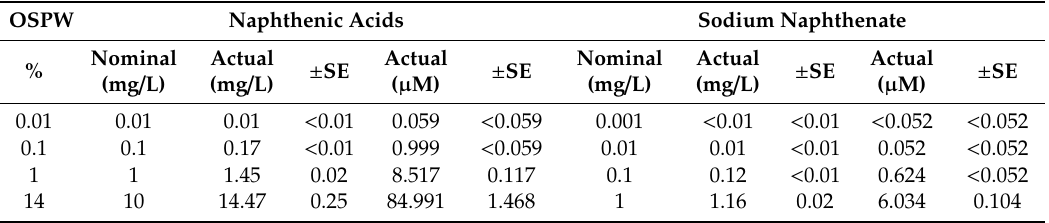
Table 1. Comparison of the actual (mean ± standard error [SE]) versus nominal concentrations of 10:1 mixture of total naphthenic acids and sodium naphthenate as determined by scanning